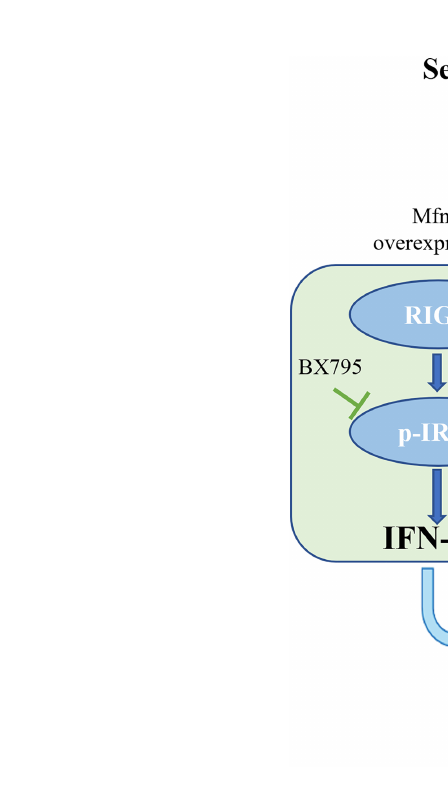
FIGURE 7 Schematic diagram of the possible mechanism of Mfn2 antiviral response. Mfn2 promote SVV proliferation mostly via down-regulating RIG-I/ IRF7-dependent IFN- l 3 protein expression